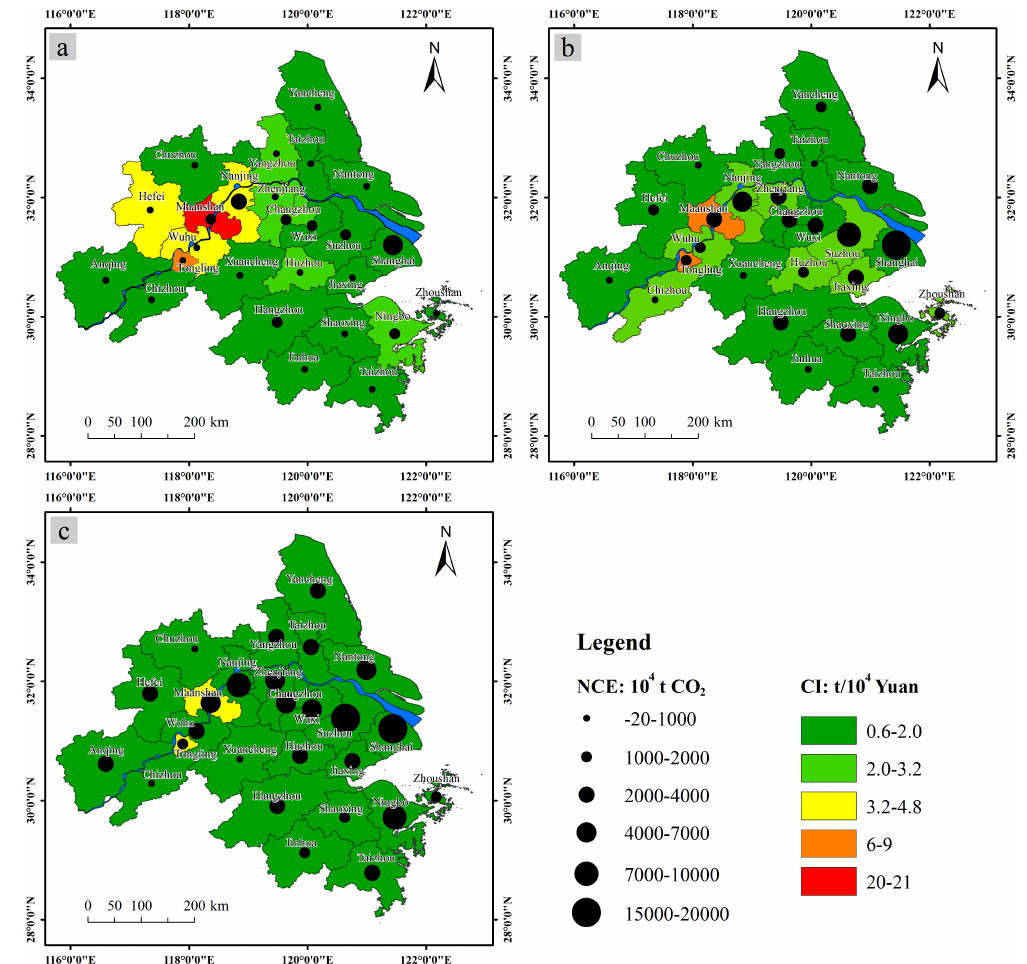
Figure 7. Net carbon emissions (NCE) and carbon intensities (CI) grading for the 26 YRDUA cities in 1995 ( a ), 2005 ( b ), and 2015 ( c ).